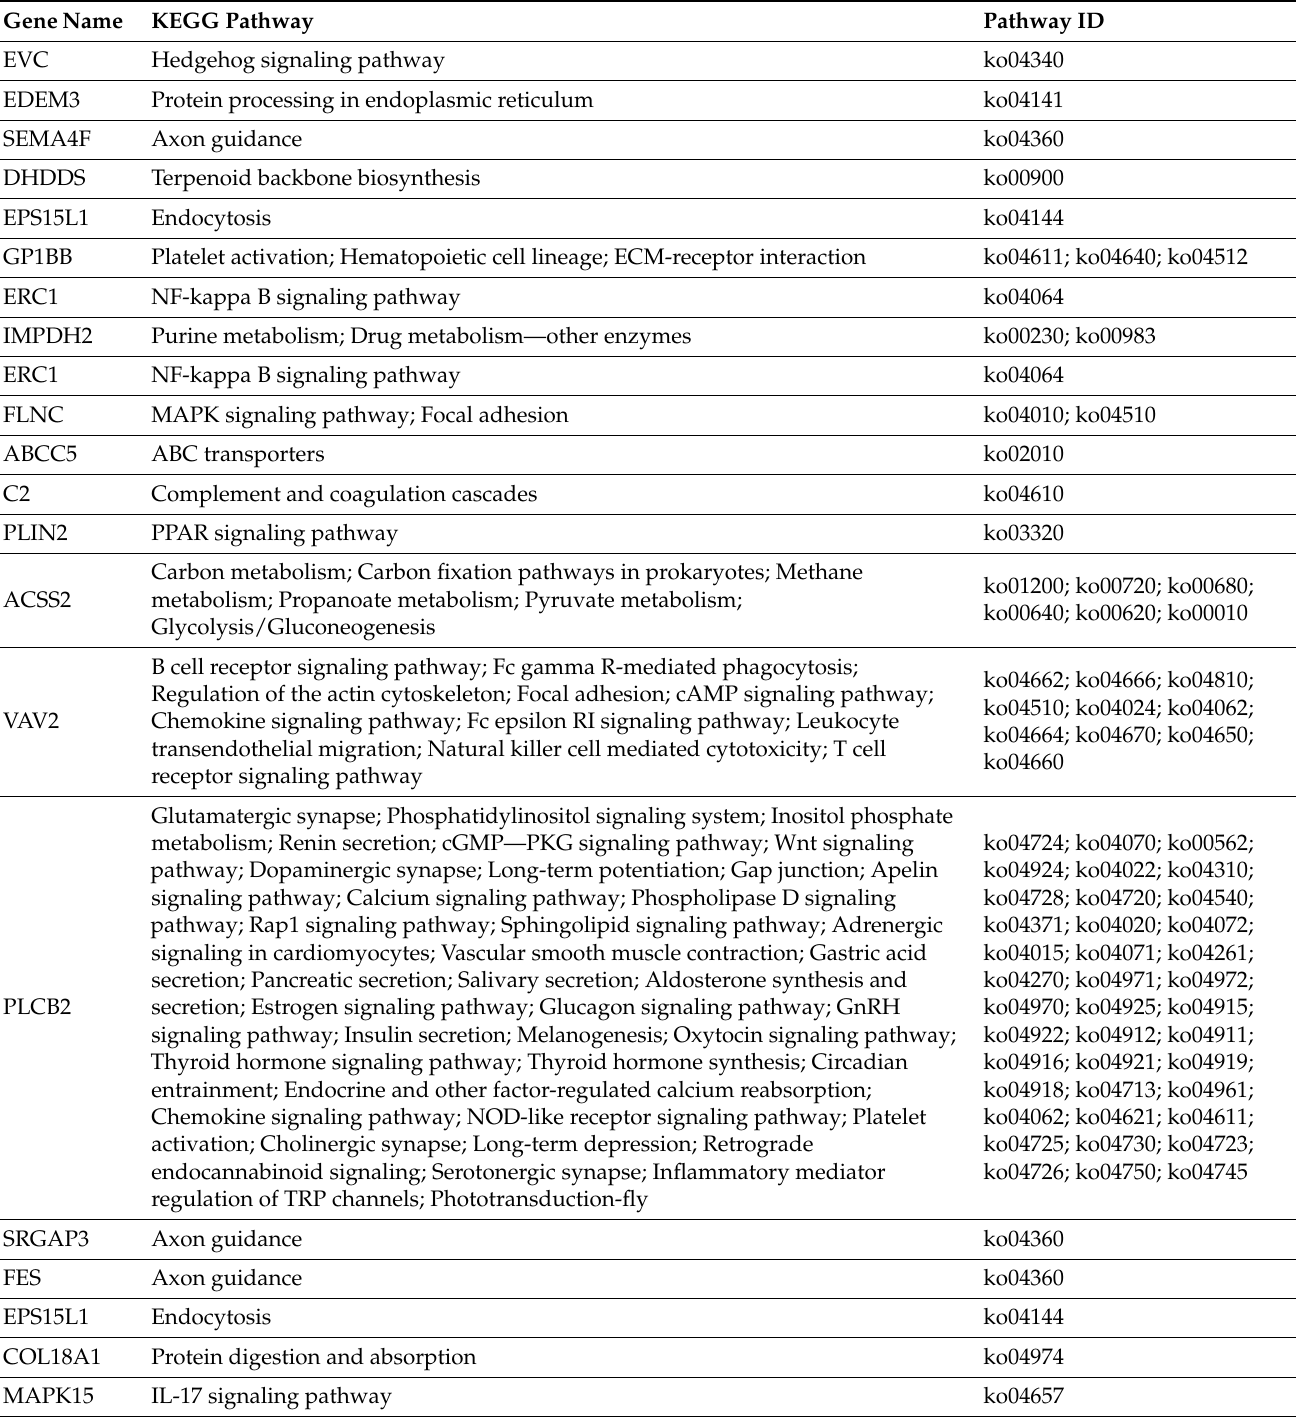
Table 5. The KEGG pathways enriched in the miRNA-mRNA co-expression network